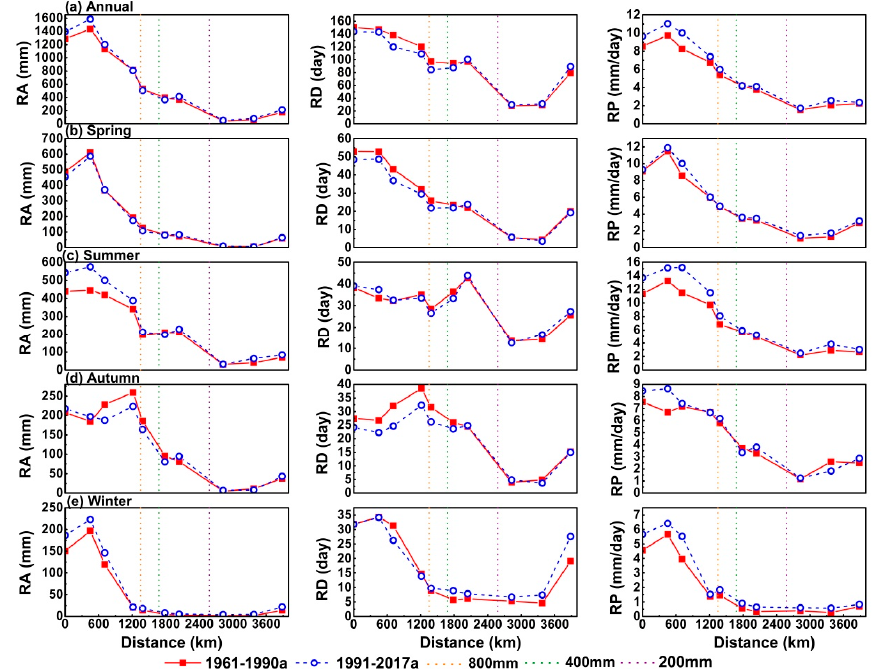
Figure 8. Changes of rainfall amount (RA), rainfall days (RD), and daily precipitation on rainy days (RP) with distance from the sea from 1961–1990 and 1991–2017, including the annual ( a ) and seasonal (including spring ( b ), summer ( c ), autumn ( d ) and winter ( e )) changes. “800 mm” represents the 800-mm precipitation contour; “400 mm” represents the 400-mm precipitation contour; “200 mm” represents the 200-mm precipitation contour.